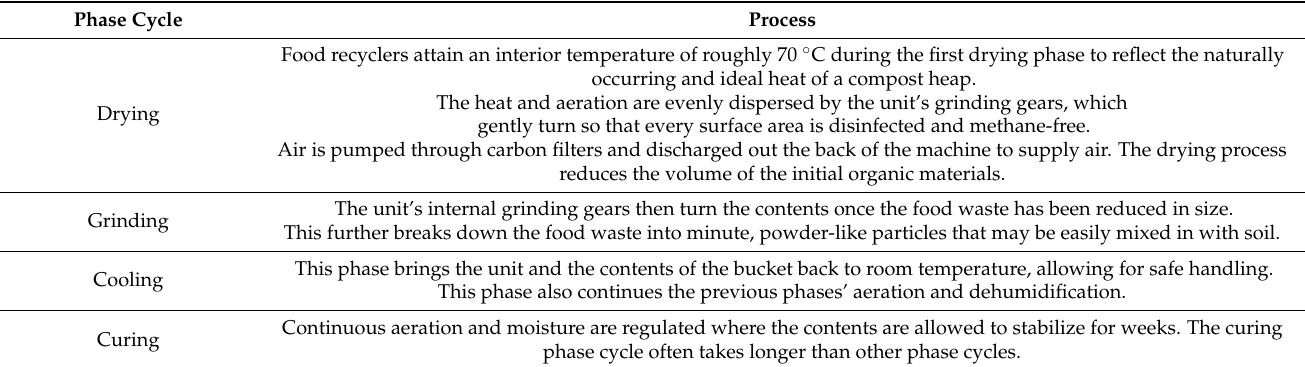
Table 2. Process descriptions of each phase cycle in an electrical home composter